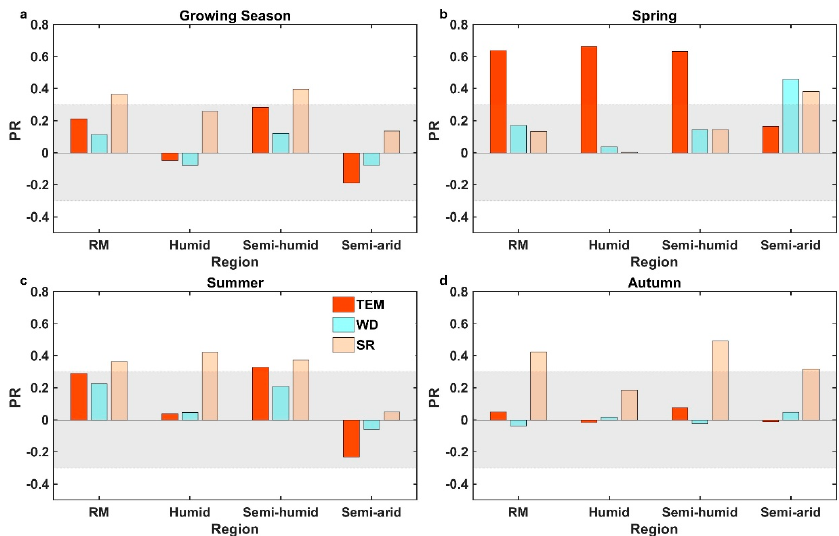
Figure 5. The partial correlation coefficients (PR) between seasonal mean NDVI and temperature (TEM), water deficit index (WD) and net solar radiation (SR) in the period 1982–2015 for the whole study region (RM) and different drought gradients. ( a – d ) is for growing season, spring, summer and autumn, respectively. The bars beyond the shaded areas indicate statistical significance ( p < 0.05). Forests 2018 , 9 , x FOR PEER REVIEW